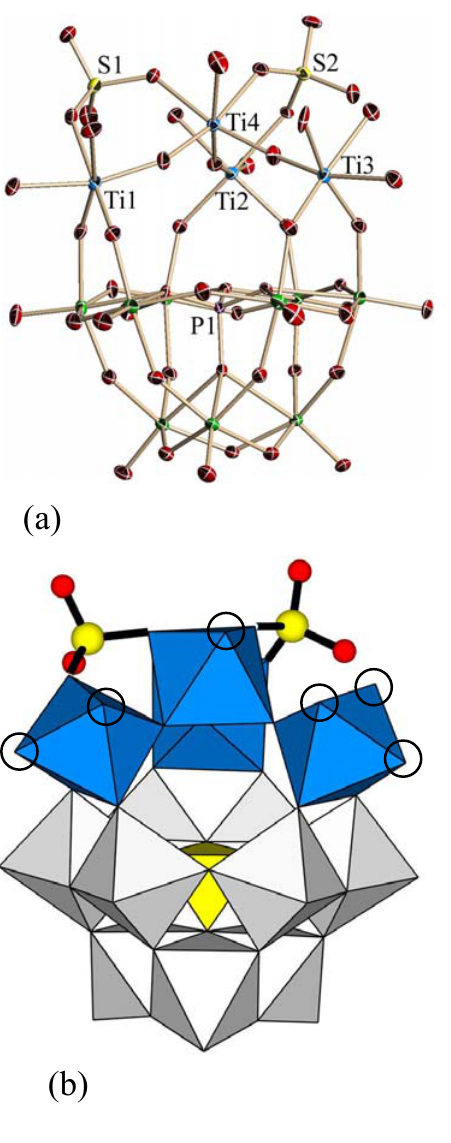
center. In (b) and (c), the four 4 octahedra are shown in gray, and the 6